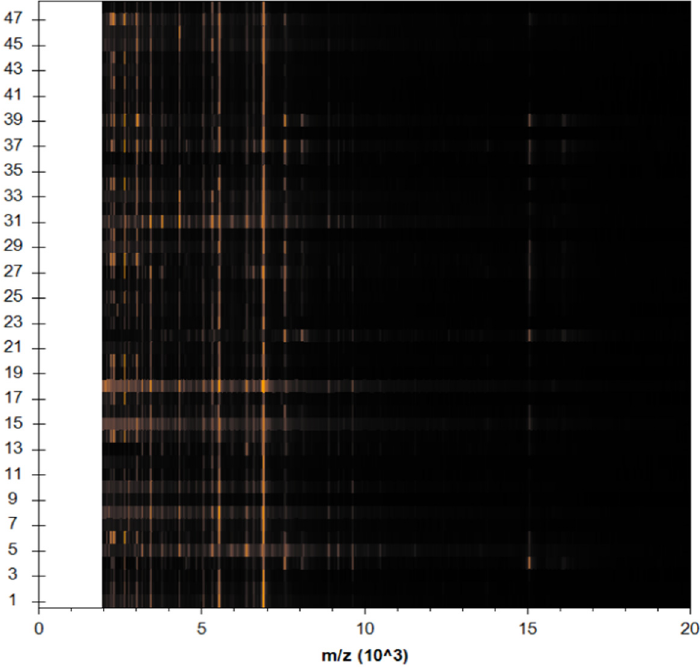
Figure 7. View of protein on a Spectra gel for 22 MRSA strains. The yellow dots represent a collection of diverse protein spectra with varying interiors.